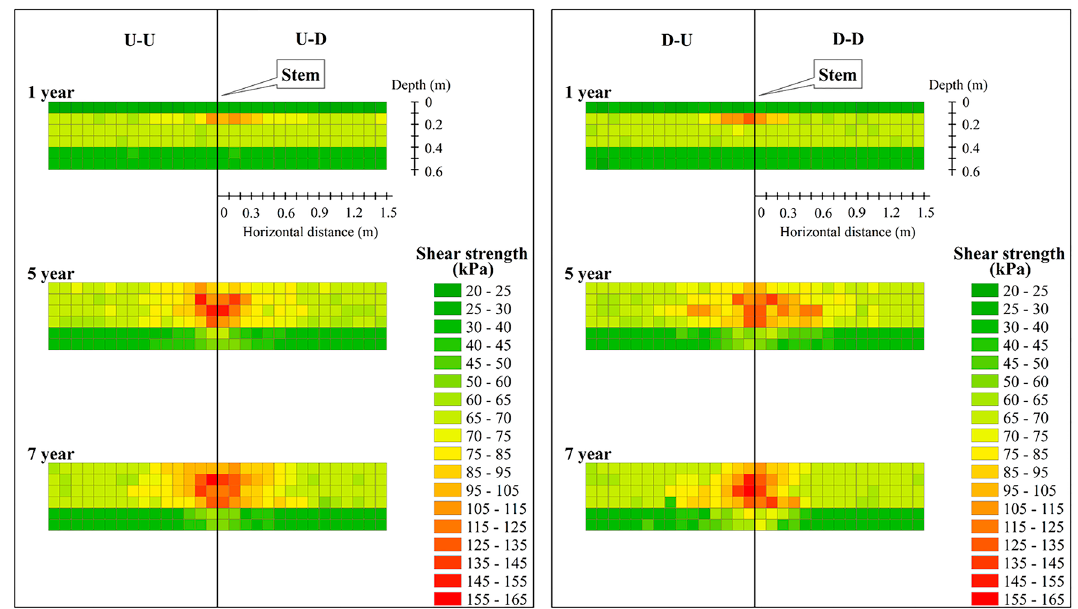
Figure 9. Spatio-temporal distribution of the soil shear strength. U-U, D-U, U-D and D-D represent the upslope-upstream face, the downslope-upstream face, the upslope-downstream face and the downslope-downstream face of the riverbank, respectively. Table 10. The shear strengths of the pure soil and the root-soil composite.